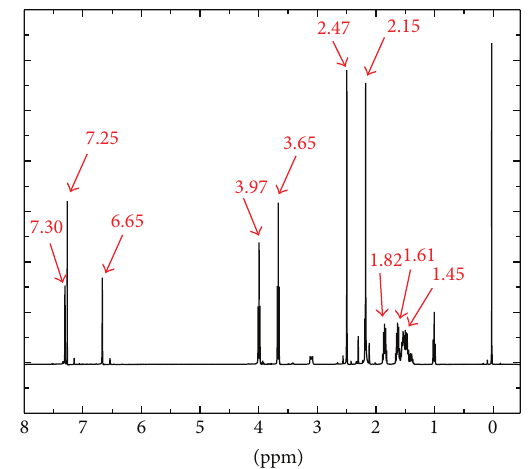
Figure 6: 1 H NMR Spectrum of 4-[(6-hydroxyhexyl)oxy]-2,5- dimethylbenzonitrile.